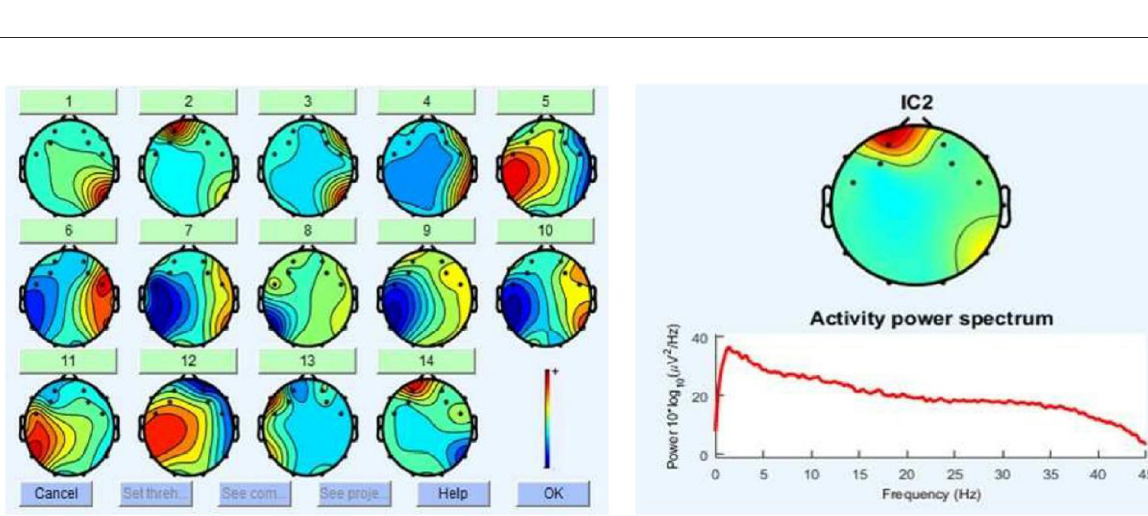
training). In both cases, a fixed effects general linear